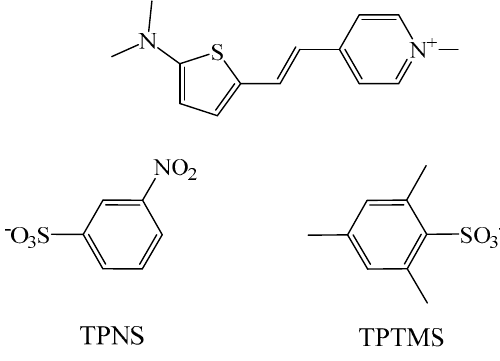
Figure 8. Molecular structures of TPNS and TPTMS.